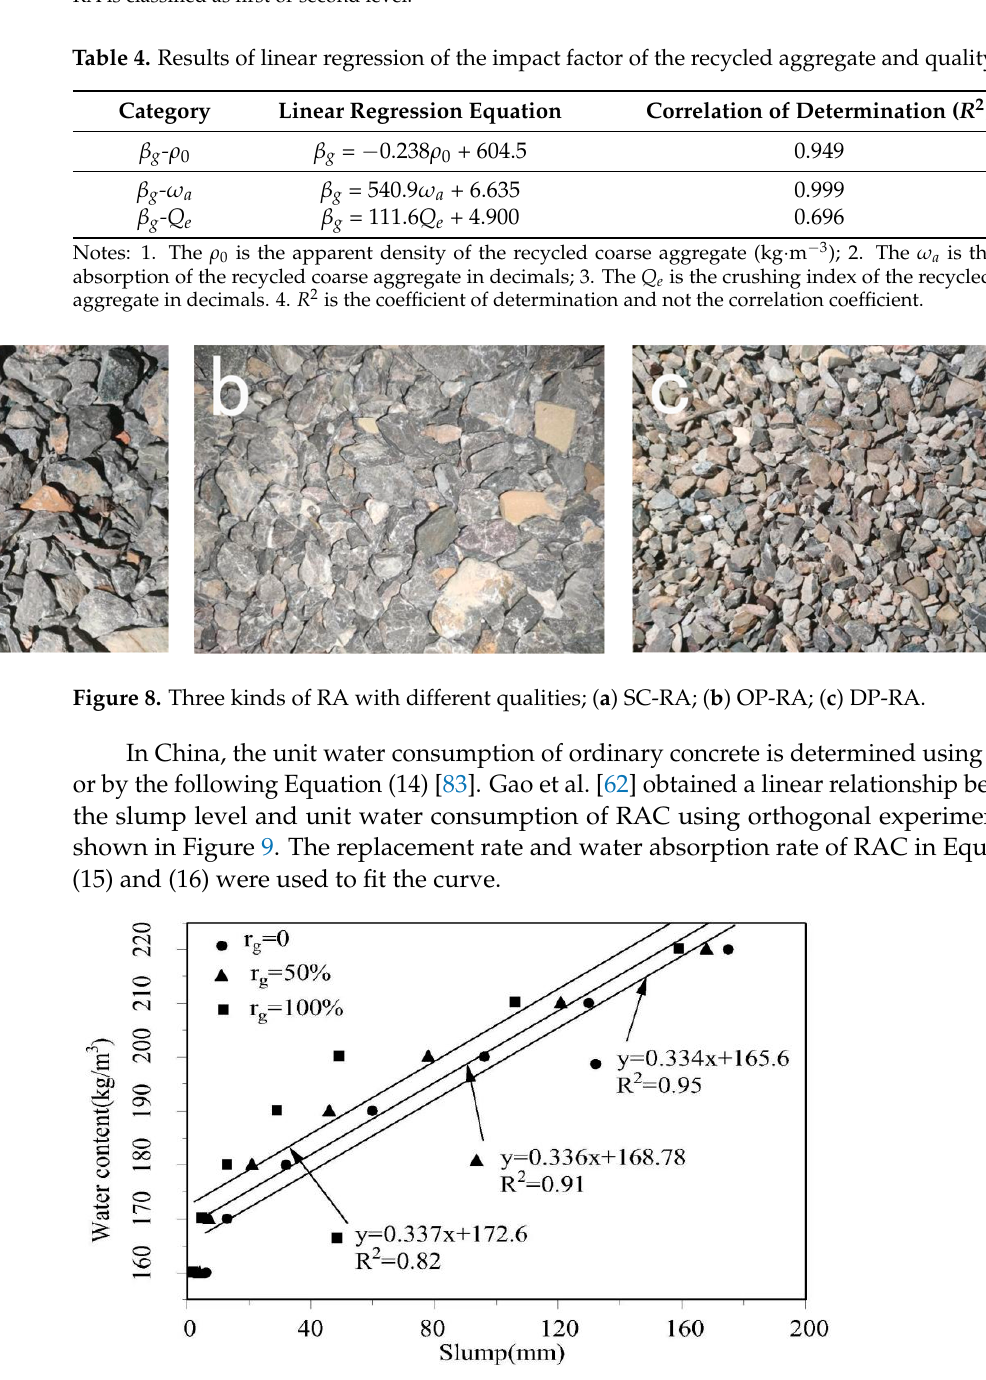
Figure 9. Relationship between the slump level and the unit water consumption of SF RAC [61].